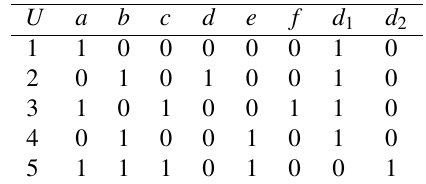
Table 1. A decision formal context K = ( U , A , I , D , J